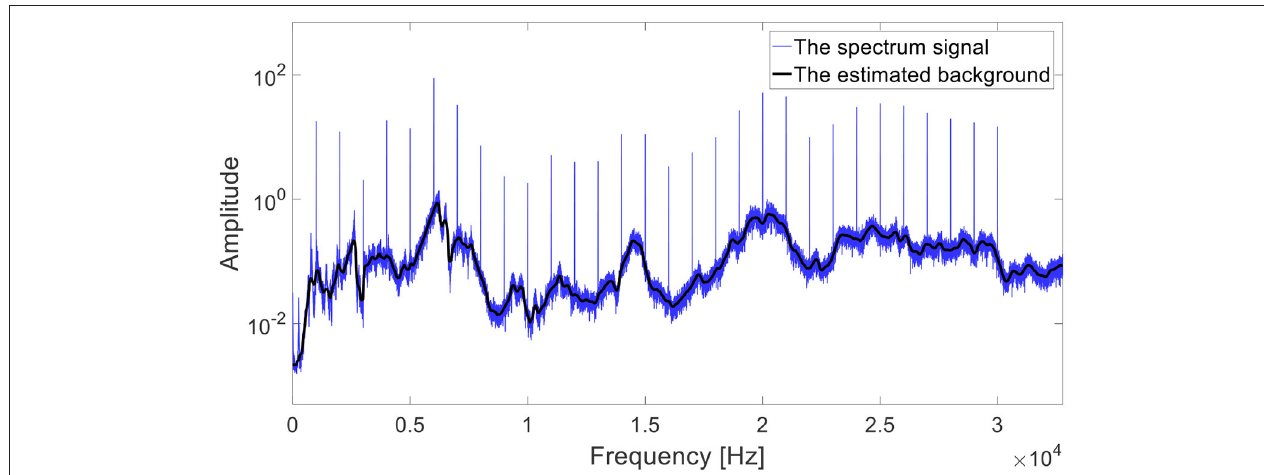
FIGURE 2 | An example of an estimated spectrum background (black) of a spectrum signal (blue).